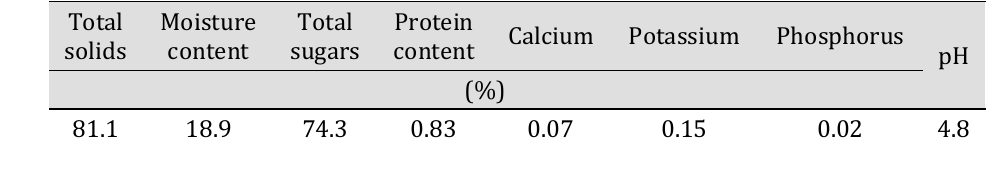
Table 1. Chemical analysis of caper honey